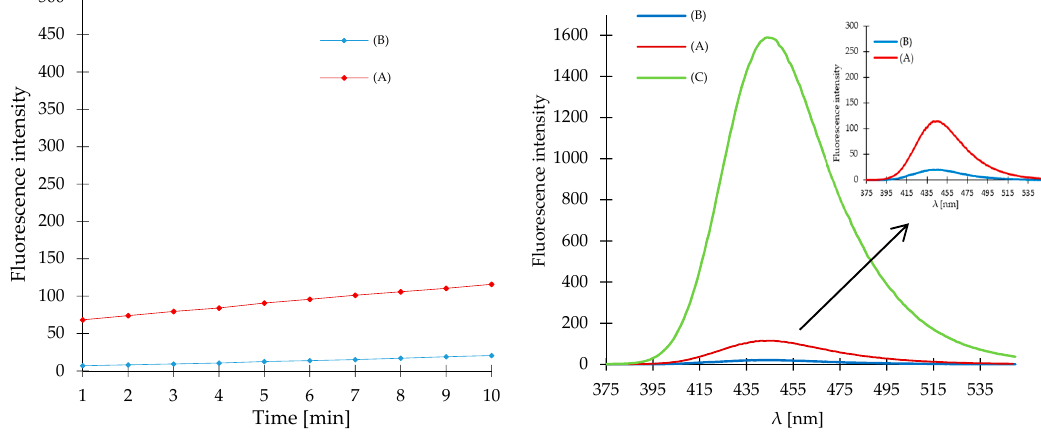
Figure 3. Time course experiment of compound 2 (0.1 mM, A) and 3 (0.1 mM, B) reacting with NaHS in sodium phosphate buffer (pH = 7.4) at room temperature. Time points represent time range from 1 to 10 min after addition of NaHS (0.1 mM). Fluorescence spectra of compound 1 (C), 2 (A) and 3 (B) were recorded for 10 min after addition of NaHS (0.1 mM).